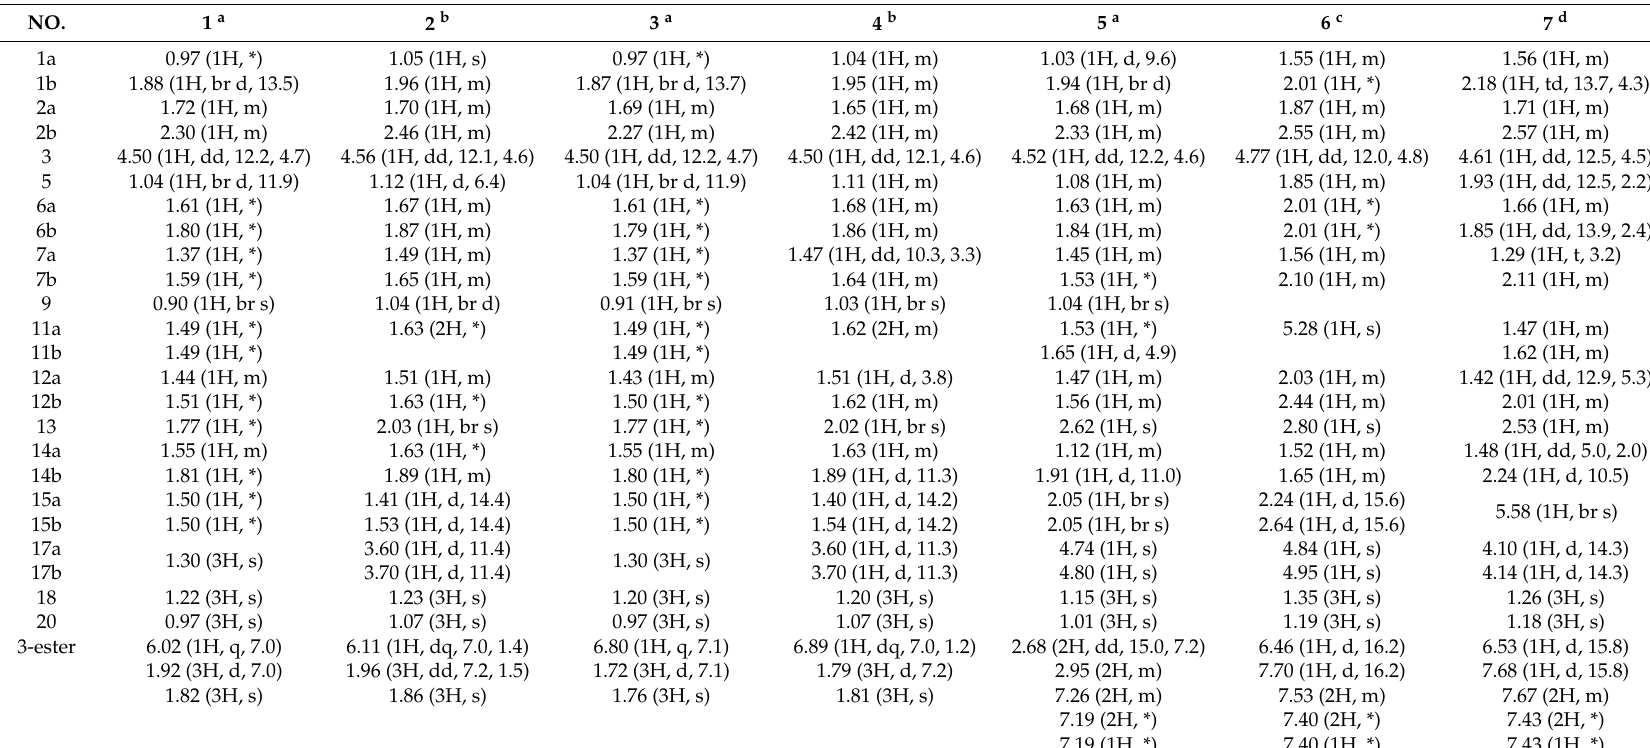
Table 1. 1 H-NMR Data for Compounds 1 – 7